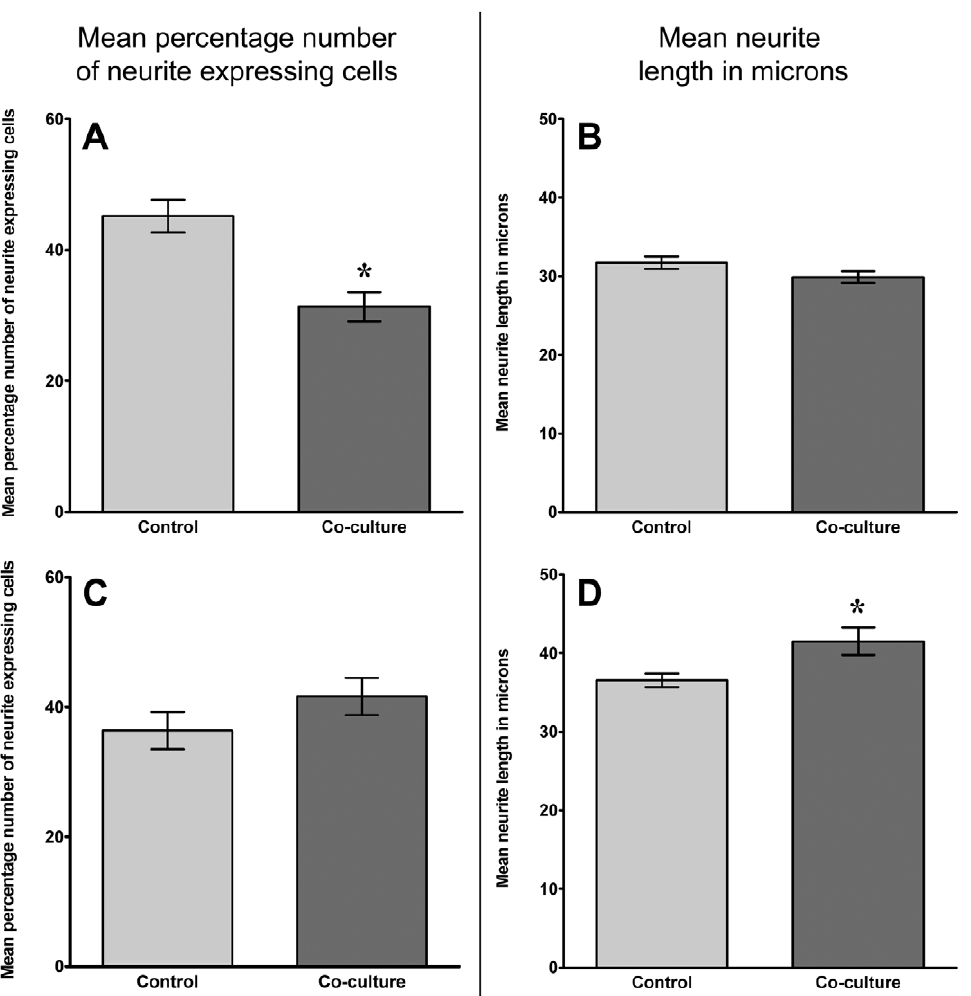
Figure 3. Analysis of neural cell behaviour following co-culture with normal and degenerate human NP cells. Histograms illustrating the percentage number of neurite expressing cells (A and C) and mean neurite length (B and D) from differentiated SH-SY5Y cells co-cultured with non-degenerate (A and B) and degenerate (C and D) NP cells without contact for 48 hours (n=3 non-degenerate, n=3 degenerate; * =P , 0.05).